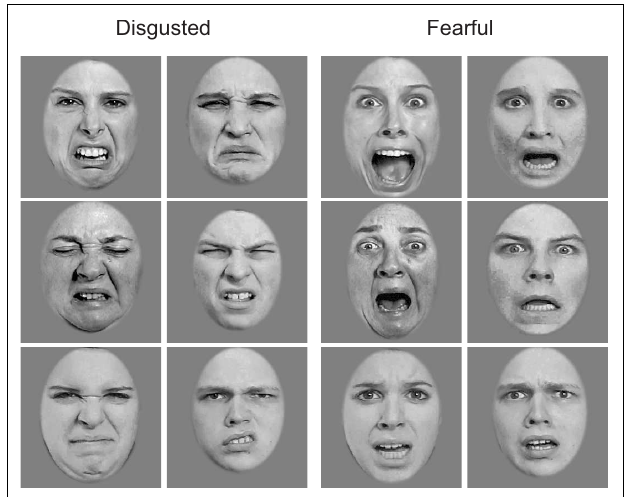
FIGURE 2 | Base face images with disgusted and fearful expressions used in the experiment.